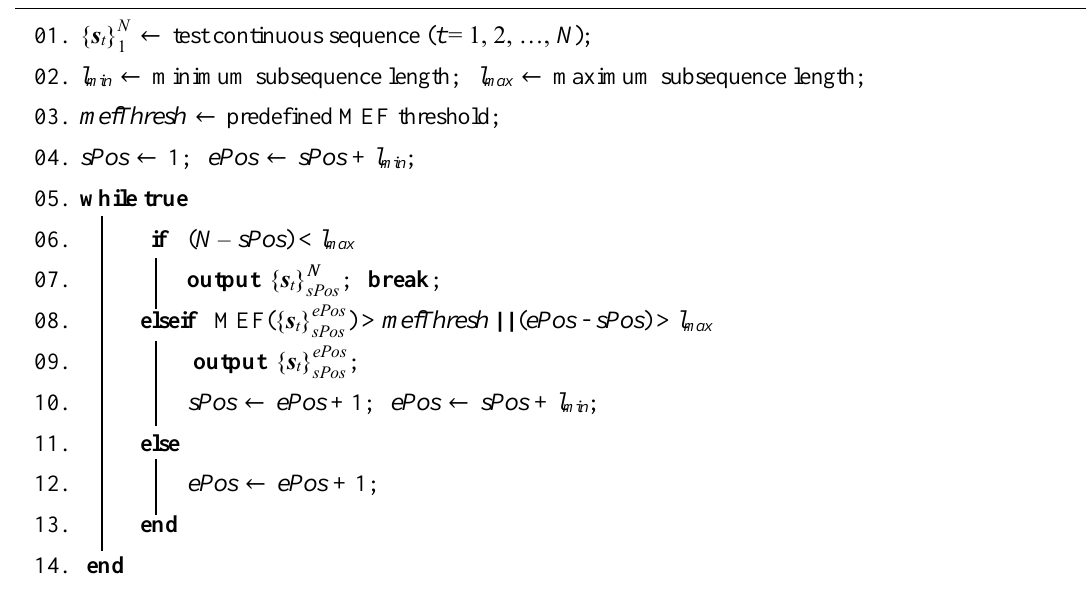
Algorithm 1. The details of our online segmentation process are given in Algorithm Algorithm 2 Online segmentation